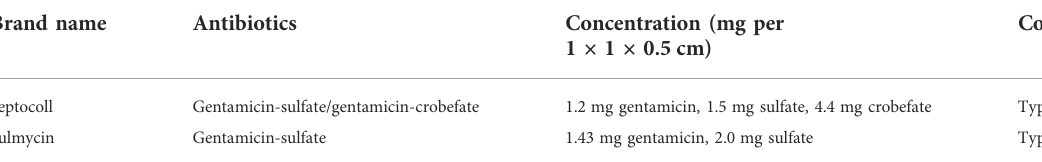
TABLE 1 Commercially available antibiotic-loaded collagen sponges.